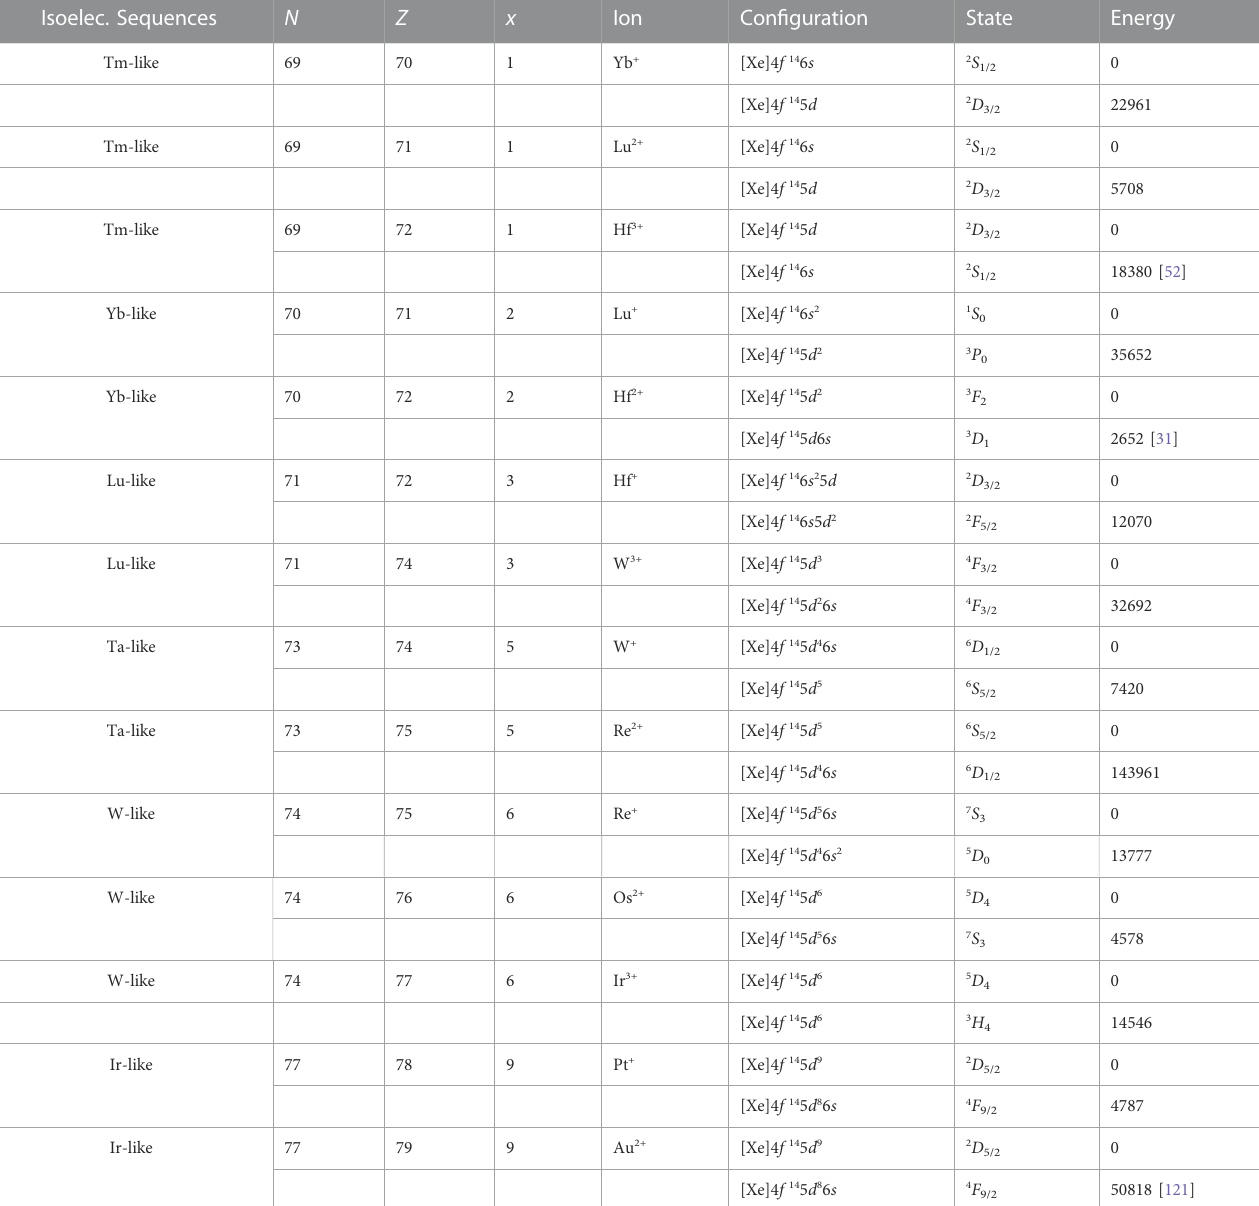
TABLE 8 The energy levels of some ions in the isoelectronic (Isoelec.) sequences of several sixth row transition metals, where N is the number of the electron, Z is the atomicnumber,and x isthenumberofvalenceelectron.[Xe] ” 1 s 2 2 s 2 2 p 6 3 s 2 3 p 6 3 d 10 4 s 2 4 p 6 4 d 10 5 s 2 5 p 6 .ThedataistakenfromtheNISTdatabaseunlesscitedothers.Units for all the values are in cm − 1 . Isoelec.